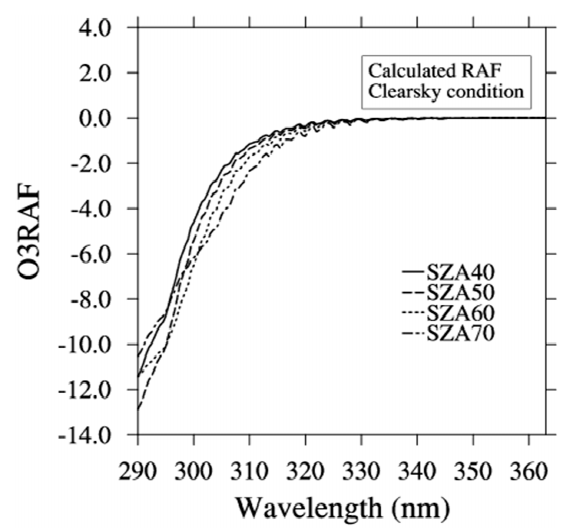
Figure 2. Averaged spectral ozone radiation amplification factor (O3RAF) including cases for all surface albedo of 0.0 to 0.5 from the RTM calculation on clear sky condition.